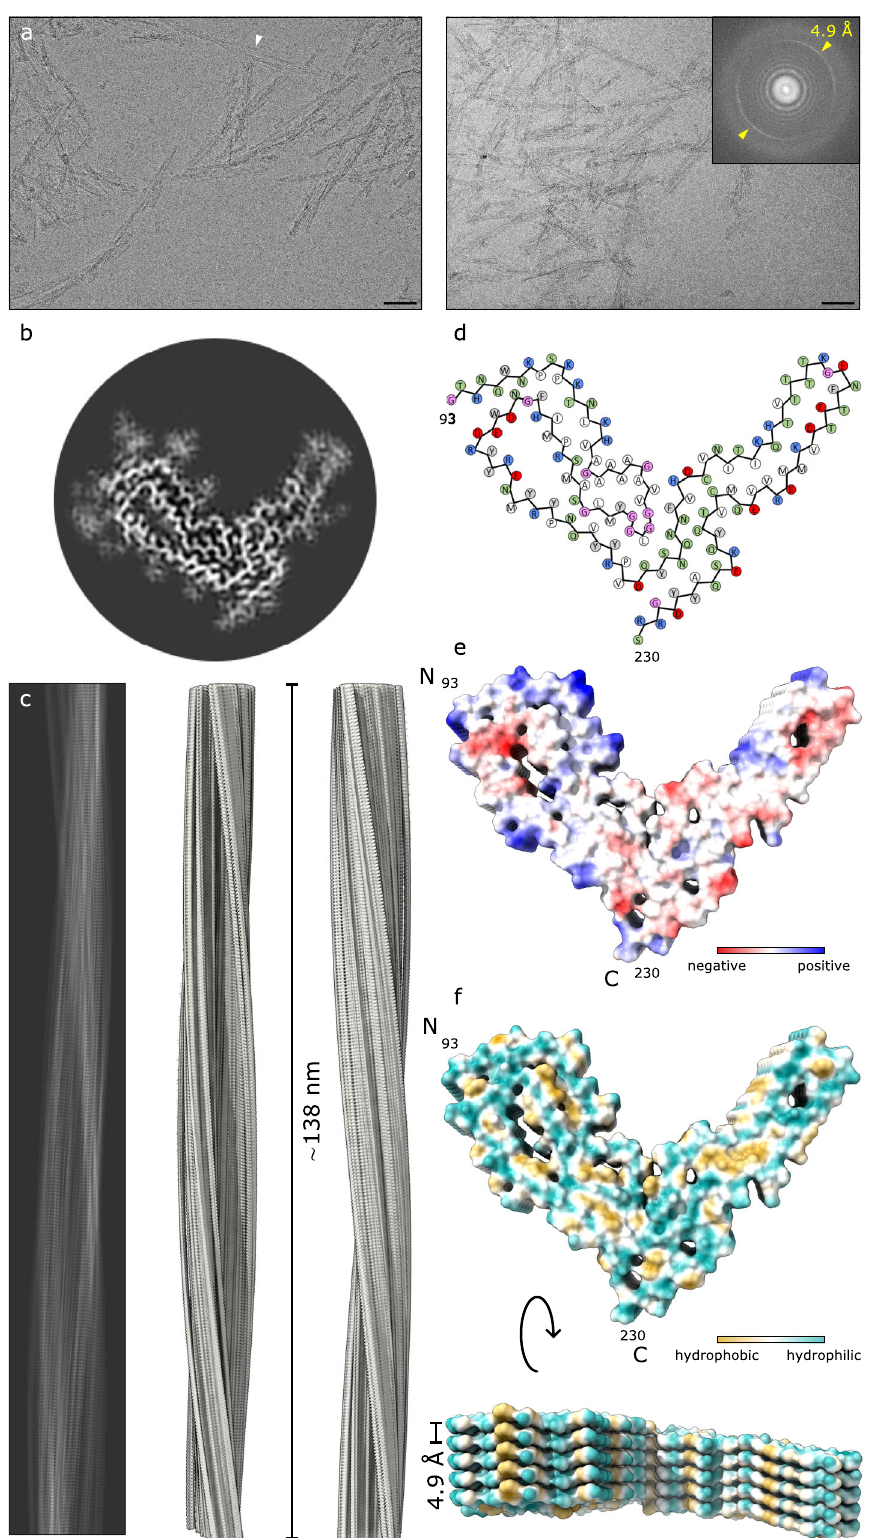
Fig. 1 Cryo-EM-based structure of aRML fi brils. a 2D cryo-EM images of aRML fi brils. Bar = 50 nm. Inset depicts associated Fast Fourier transform showing signals from regular 4.9 Å spacings (yellow arrows). The white arrowhead indicates a rare example of aRML fi brils that appear to be paired. Micrographs shown are representative of 2272 movies collected for subsequent image processing and single particle analysis (see the “ Methods ” section). b Cross-sectional view of a density map projection. c Lateral view of the fi bril density map with cross-over distance as indicated. d Core sequence showing relative orientations of side chains. Green, polar; blue, basic; red, acidic; white, aliphatic; gray, aromatic; pink — glycine. e Coulombic charge representation. f MLP hydrophobicity surface plot demonstrating interspersed hydrophobic